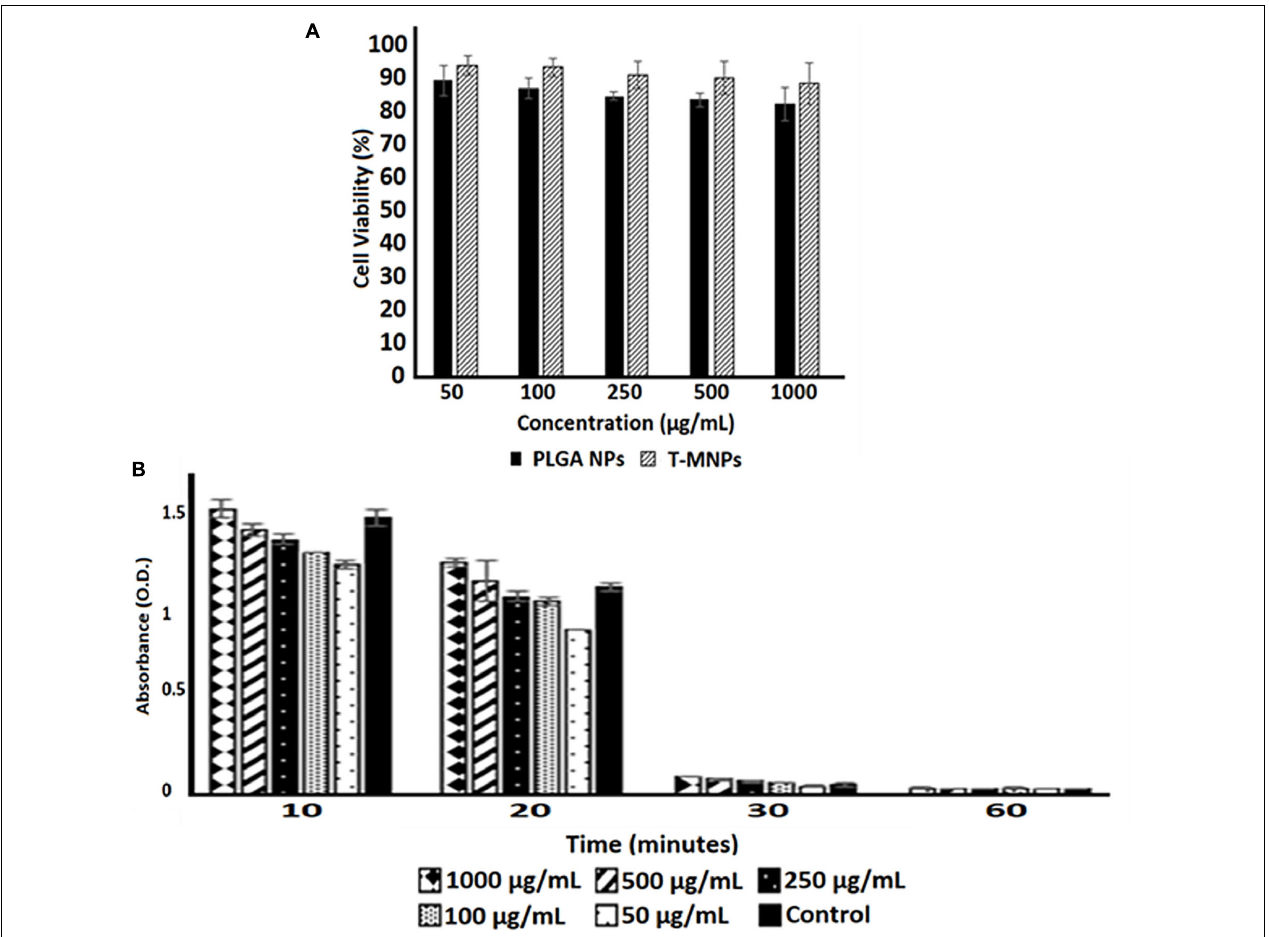
FIGURE 5 | Cyto-/Hemo-compatibility of T-MNPs. (A) Cyto-compatibility of T-MNPs was analyzed on human dermal fibroblasts (HDFs) at varying NPs concentrations (50—1,000 µ g/ml) for 24 h, and cell viability was quantified using MTS assays ( n = 3). (B) Blood clotting kinetics of T-MNPs. Clotting efficiency was measured in absorbance units (OD) of the supernatants collected from T-MNPs treated blood samples at pre-determined time-points: 10, 20, 30, and 60 min. The absorbances were quantified using a UV-vis Spectrophotometer ( n =